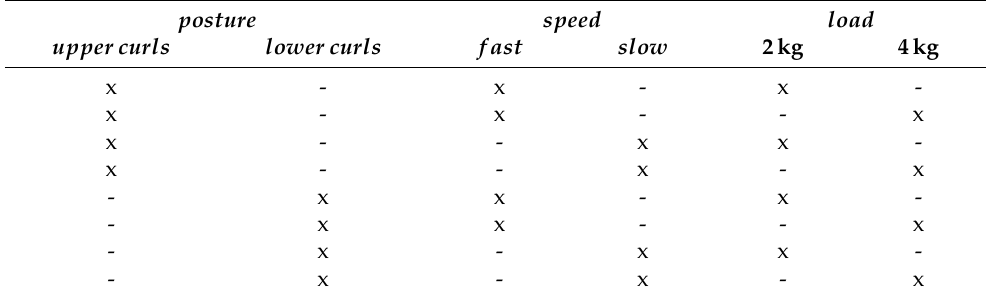
Table A2. Listing of all experimental conditions per